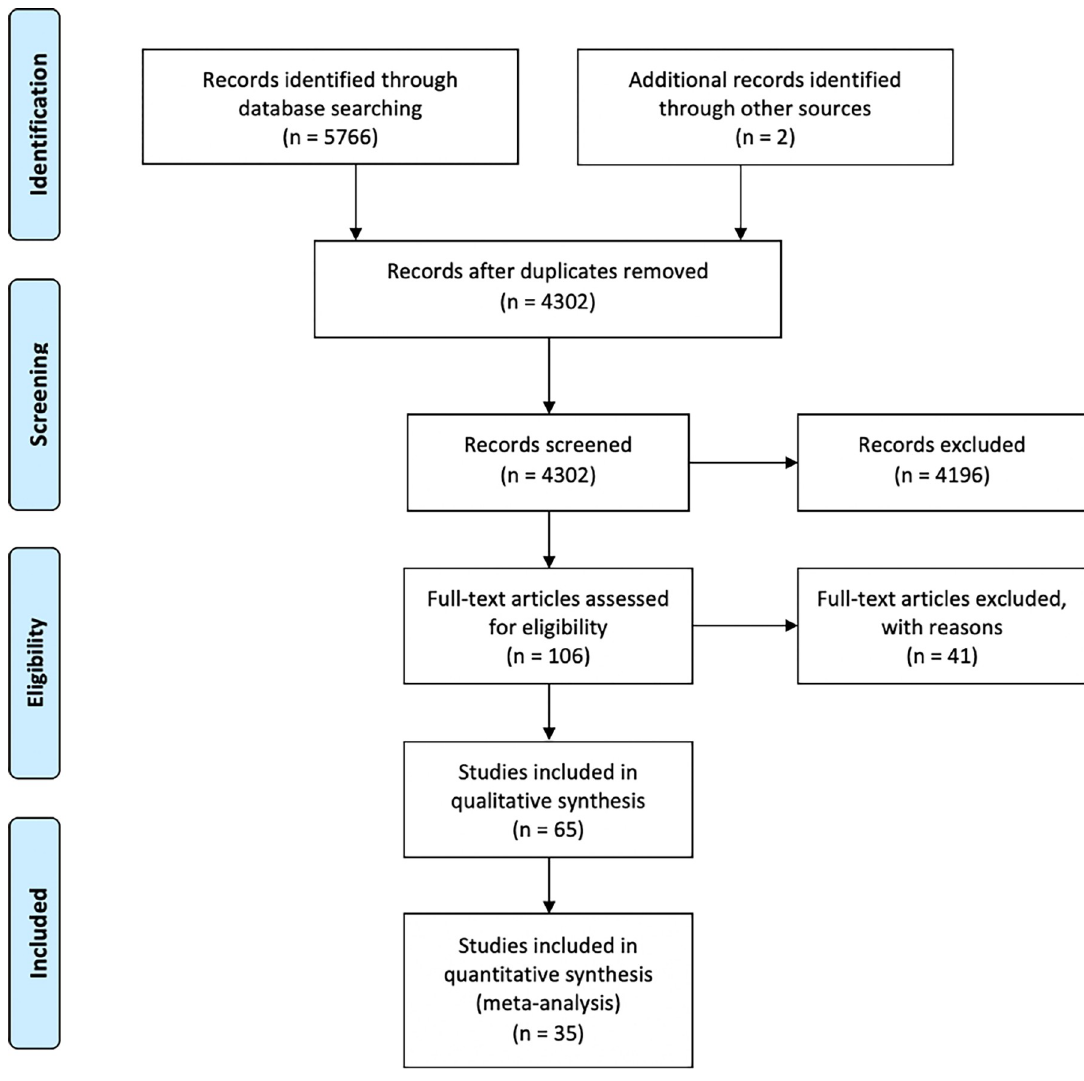
Fig 1. PRISMA flow